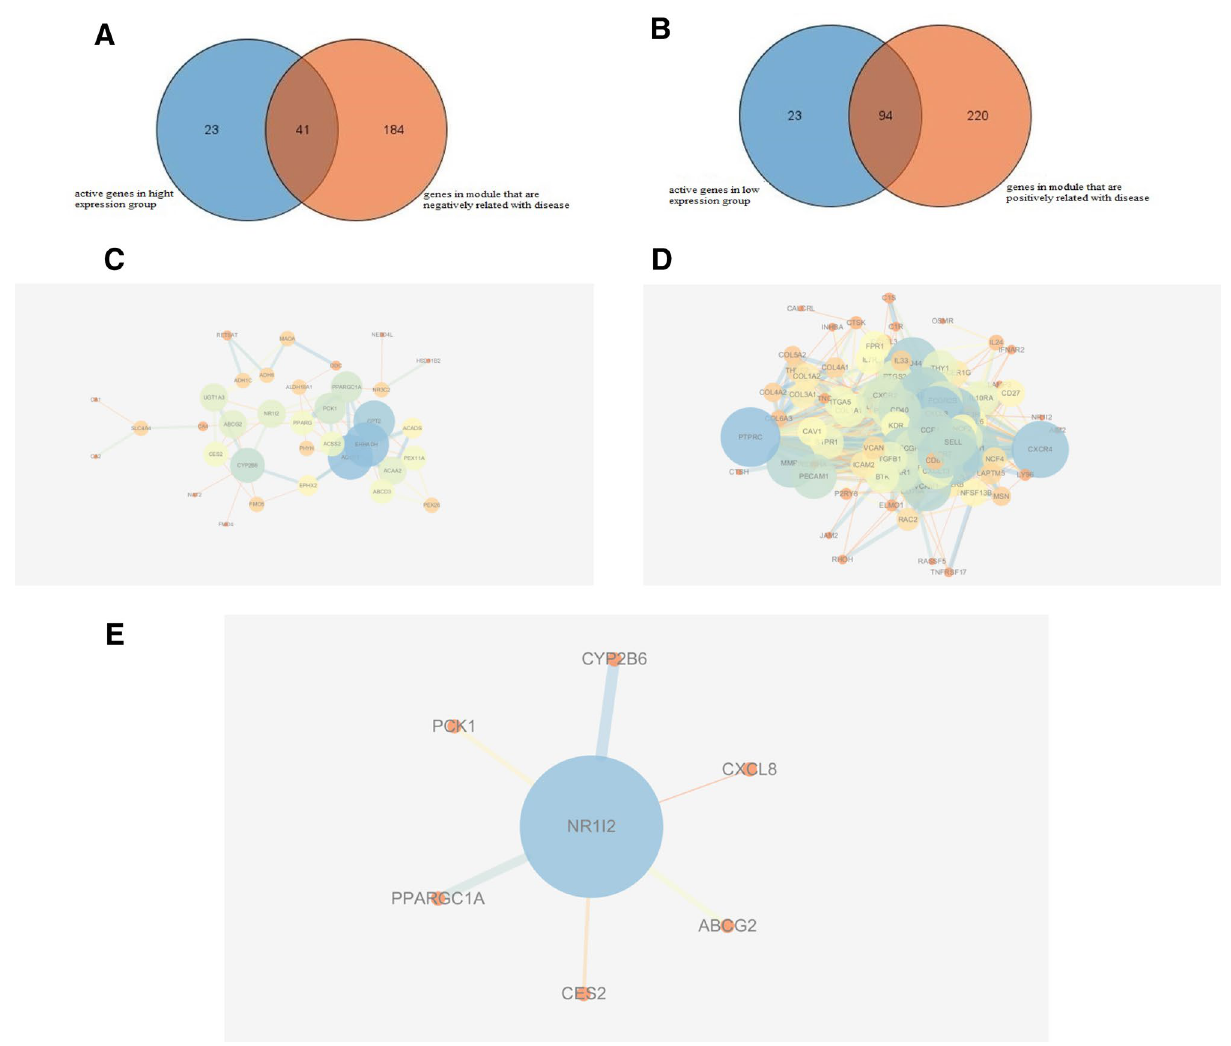
Figure 5. Intersection analysis and protein–protein interaction network with PXR. ( A ) Gene set 1 was constructed by the intersection between the active genes in high expression group after GSEA and the genes in module that are negatively correlated with disease after WGCNA. ( B ) Gene set 2 was constructed by the intersection between the active genes in low expression group after GSEA and the genes in module that are positively correlated with disease after WGCNA. ( C ) PPI-network of 94 overlapping gene in gene set 1. ( D ) PPI- network of 41 overlapping gene in gene set 2. ( E ) CES2, ABCG2, PCK1, PPARGC1A and CYP2B6 from gene set 1 and CXCL8 from gene set 2 were predicted to interact and functionally associate with PXR.